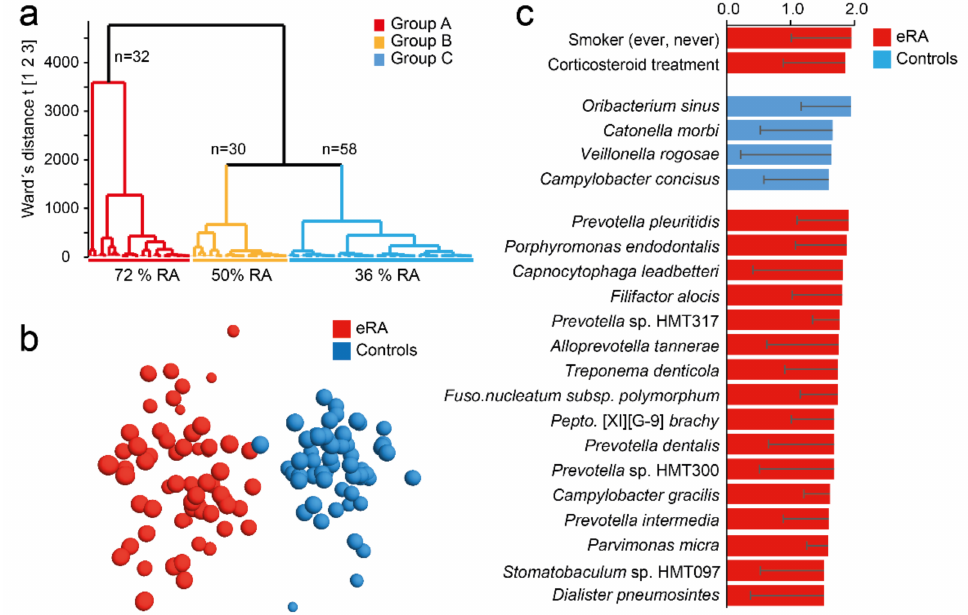
Figure 2. Saliva microbiota hierarchical cluster groups and early onset RA prevalence. ( a ) Dendro- gram from hierarchical clustering based on 16S rDNA sequencing defined taxa in saliva samples. ( b ) OPLS-DA loading scatter plot based on a model including early-onset RA (eRA) and healthy subjects (controls) as dependent variable (Y) and abundance of species, phylotypes and genera detected in saliva samples as the independent variable block (X). ( c ) Bar graph showing top 20 bacterial species and smoking status influential in the OPLS-DA model and expressed as Variable Importance in Projection (VIP) values with 95% confidence interval. Red colour represents eRA and blue colour healthy controls. For a full list of VIP values see Table